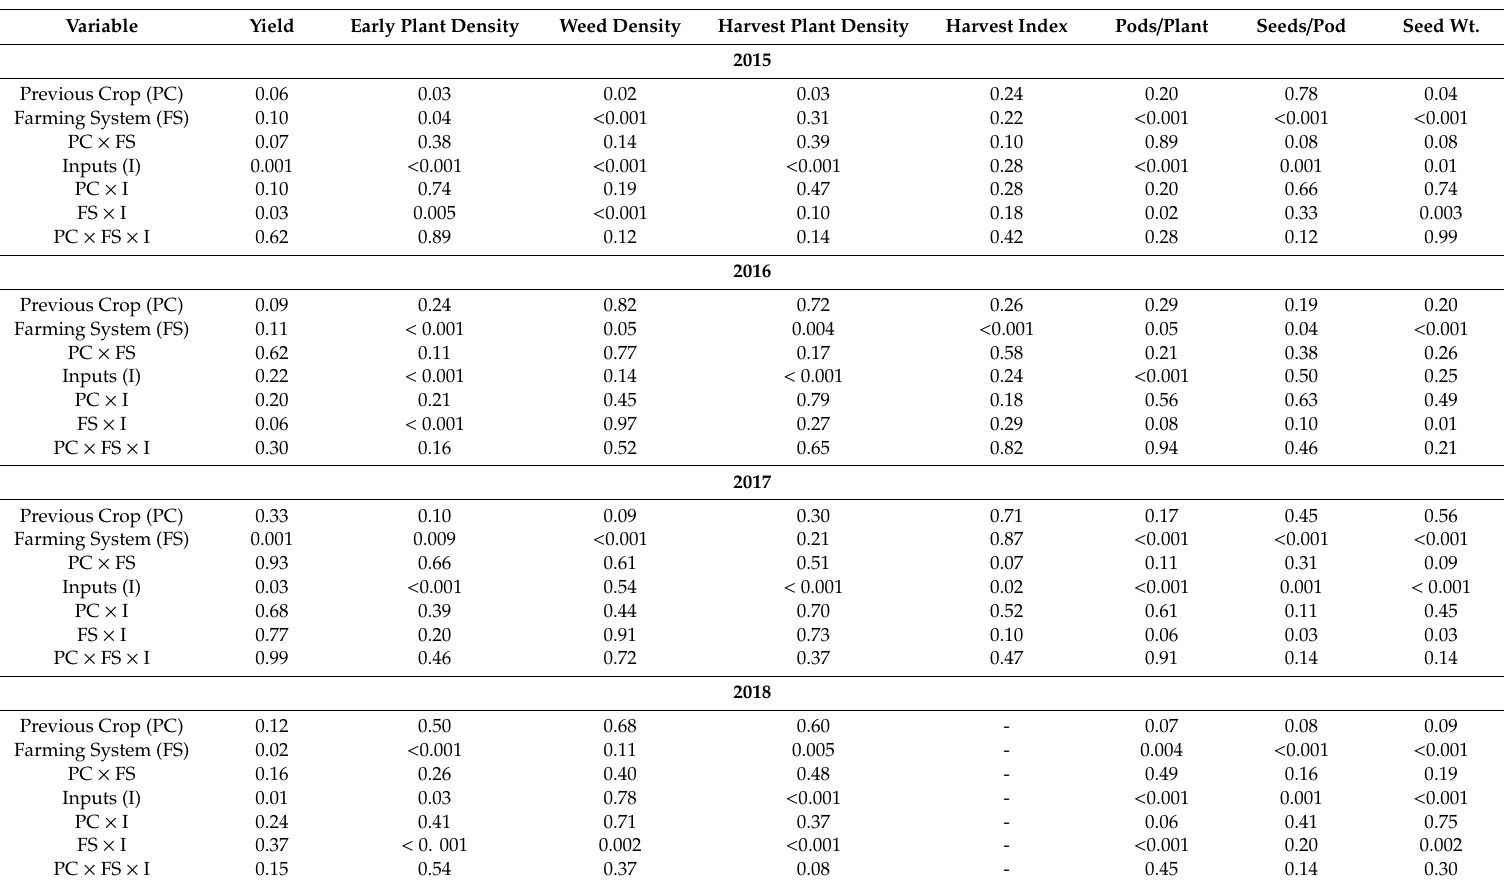
Table 3. P -values for yield, early plant density, weed density, harvest plant density, harvest index, pods / plant, seeds / pod and seed weight in 2015, 2016, 2017 and 2018 on a University research farm in central New York,